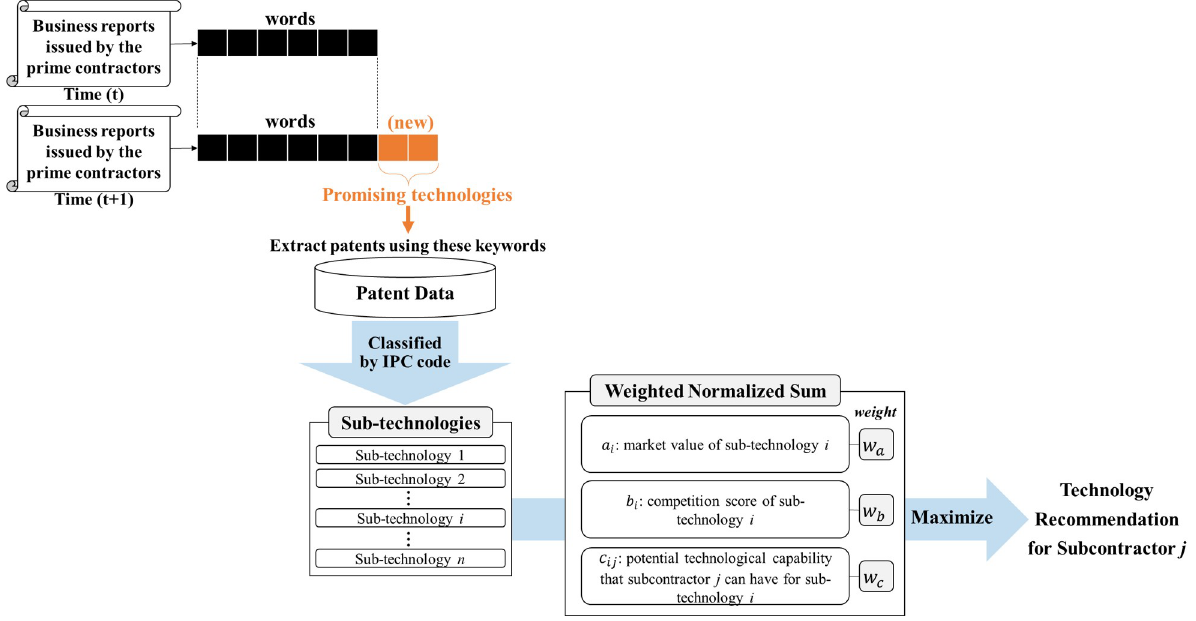
Fig 1. Flow chart of the proposed